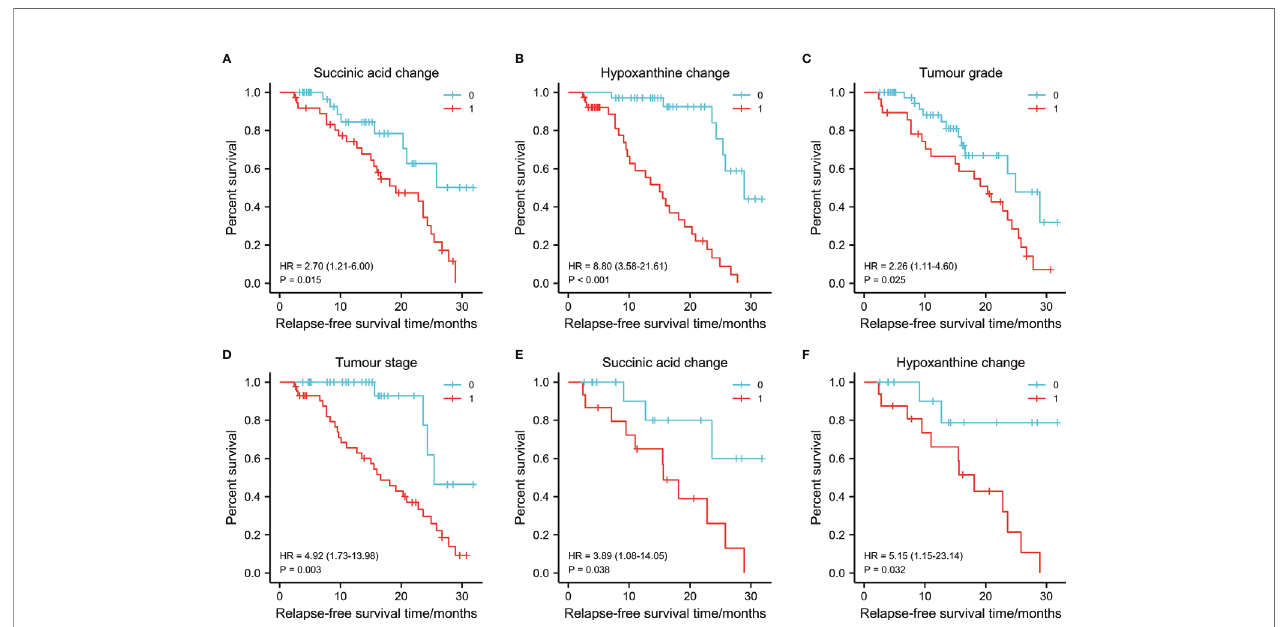
FIGURE 5 | Graphs (A – D) showing the 3-year survival rates of succinic acid change, hypoxanthine change tumor stage, and tumor grade in 73 oral squamous cell carcinoma (OSCC) patients (training set) using the Kaplan – Meier method and log-rank test. (A) Succinic acid change-low had a higher 3-year recurrence-free survival (RFS) rate than succinic acid change-low (1) (79.4% vs. 30.8%, p = 0.015). (B) Hypoxanthine change-high had a higher 3-year RFS rate than hypoxanthine-low (81.6% vs. 22.9%, p < 0.001). (C) Grade I (well differentiated) had a higher 3-year RFS rate than grade II/III (moderately or poor differentiation) (53.3% vs. 17.9%, p = 0.025). (D) Early T stage (T1/T2) had a higher 3-year RFS rate than late T stage (T3/T4) (86.7% vs. 55.9%, p = 0.003). Graphs (E) and (F) show the 3-year survival rates of succinic acid change and hypoxanthine change in 30 OSCC patients (test set) using the Kaplan – Meier method and log-rank test. (E) Succinic acid change- low had a higher 3-year RFS rate than succinic acid change-low (62.4% vs. 42.8%, p < 0.038). (F) Succinic acid change-low had a higher 3-year RFS rate than hypoxanthine-low (65.6% vs. 41.6%, p = 0.032). 0 in graphs (A – F) represents succinic acid change-low, hypoxanthine change-high, grade I, early T stage (T1/T2), succinic acid change-low, and succinic acid change-low, respectively. 1 in graphs (A – F) represents succinic acid change-high, hypoxanthine change-low, grade II/III, late T stage (T3/T4), succinic acid change-low, and succinic acid change-high, respectively.